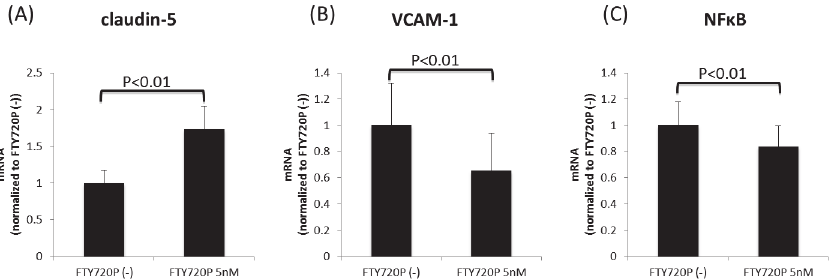
Fig 4. The effects of pretreatment with fingolimod-phosphate on the mRNA expression. The effects of pretreatment with fingolimod-phosphate on the mRNA expression of claudin-5 , VCAM-1 and NF κ B in the human brain microvascular endothelial cells in the presence of MS sera were determined using a quantitative real-time PCR analysis. Pretreatment with fingolimod-phosphate resulted in the significant upregulation of the expression levels of claudin-5 mRNA (A) and the downregulation of the expression levels of both VCAM-1 and the p65 subunit of NF κ B in the BMECs (B)(C) compared with that observed in the cells not pretreated with